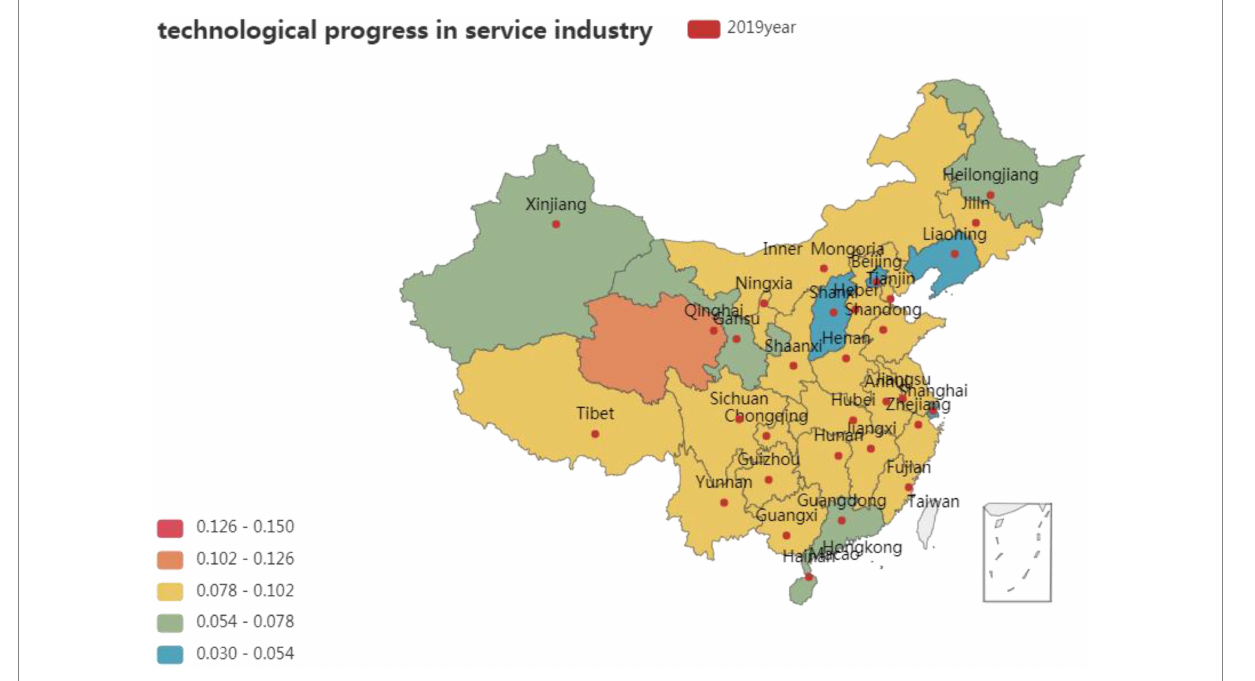
FIGURE 1 North–south gap of technological progress in green development of China’s service industry.